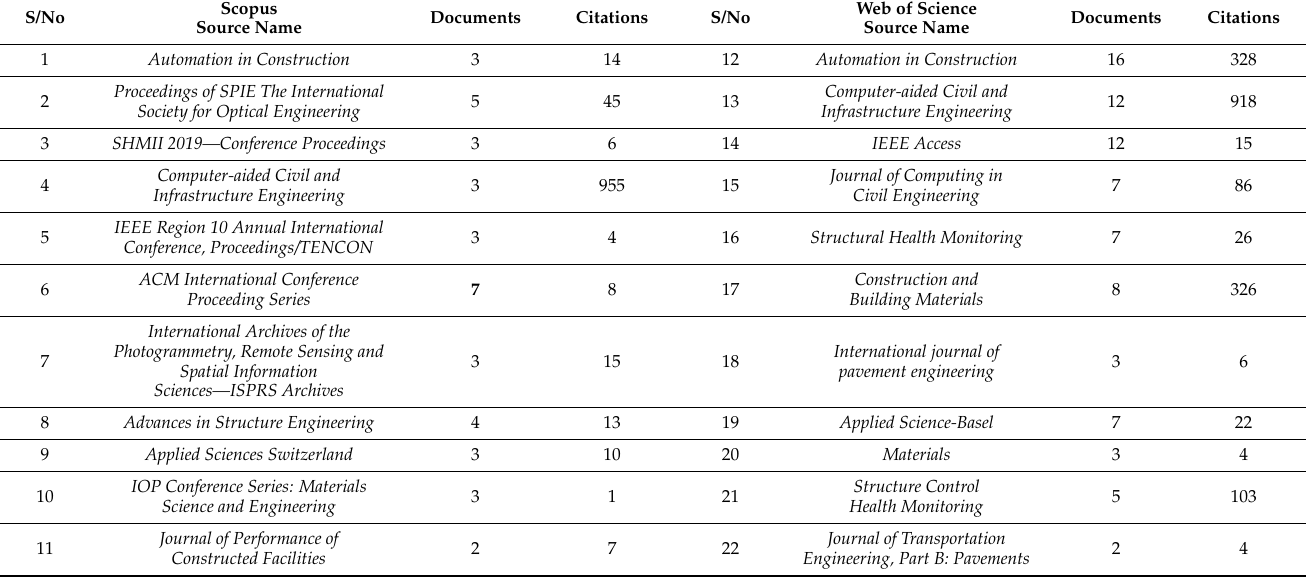
Table 3. Top Scopus and WoS contributors.